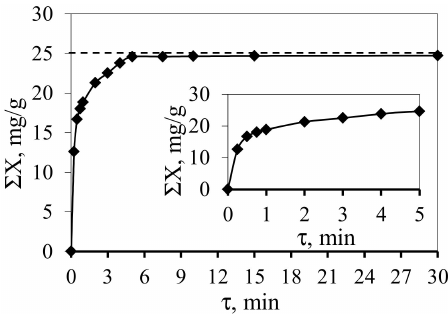
Figure 2. Integral kinetic Curve of Co 2+ ion adsorption by α -C 2 SH, when the initial concentration of Co 2+ was equal to 0.25 g/dm 3 .